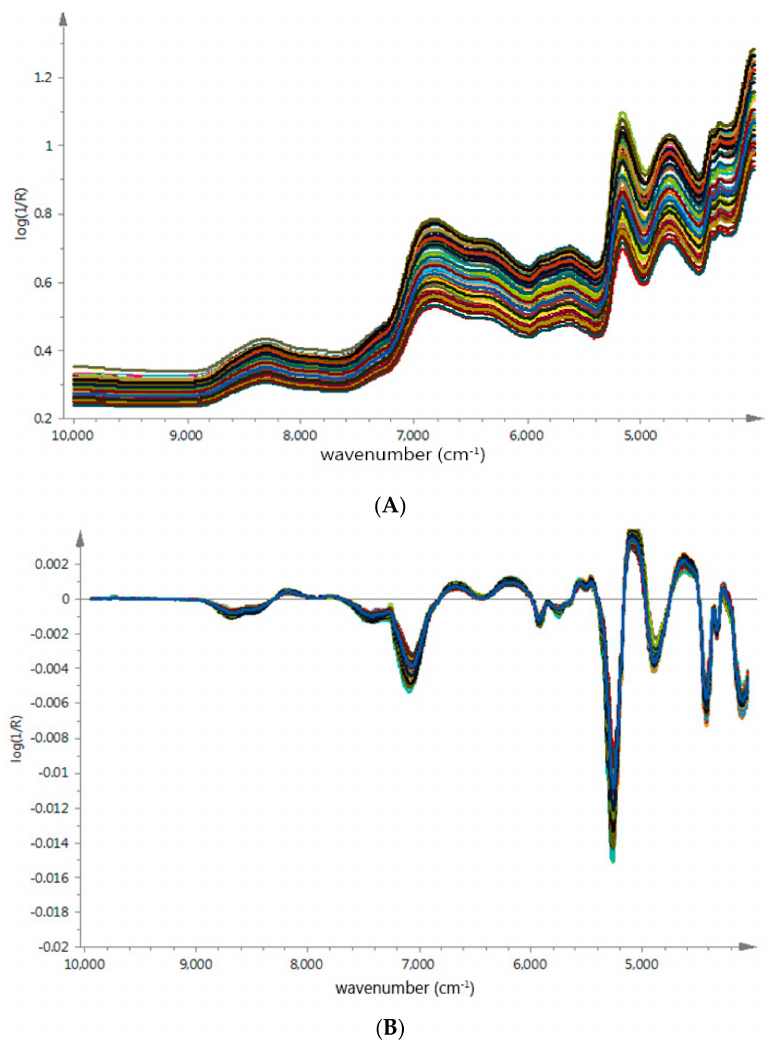
Figure 3. ( A ) The raw absorbance spectra of G. elata samples from different geographical origins; ( B ) Preprocessed spectra using Savitzky-Golay (SG) and FD pretreatment of G. elata samples from different geographical